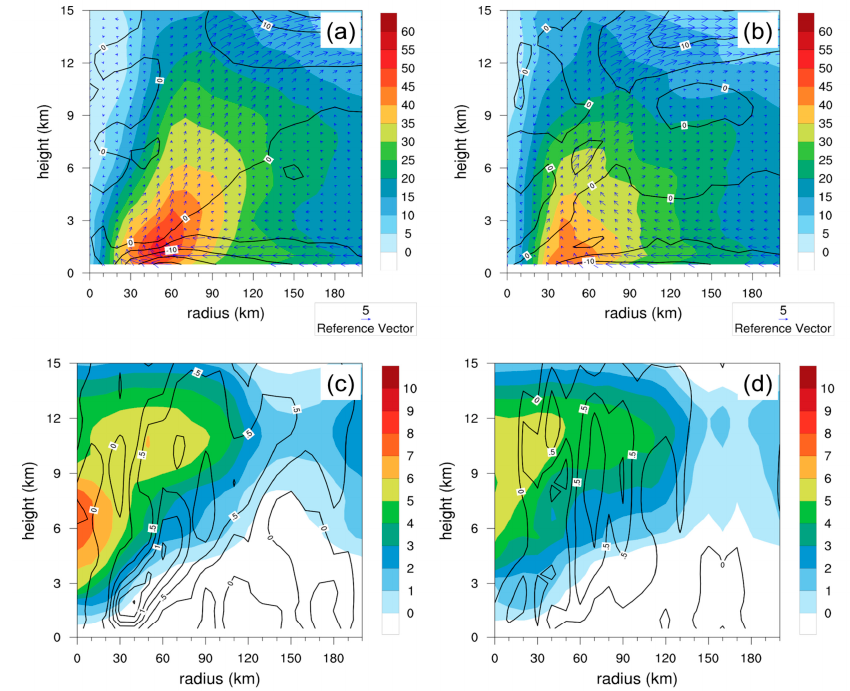
Figure 10. The azimuthally averaged: ( a ) tangential (shaded; ms − 1 ) and radial (contour; ms − 1 ) wind speeds, and secondary circulation (vectors, ms − 1 ), ( c ) temperature anomaly (shaded; °C) and vertical velocity (contour; ms − 1 ) for the V2D2 domain. ( b , d ) as in ( a , c ) but for the V1D3 domain, respectively. Results are for a 6-h forecast starting on 0000 UTC 29 July 2017.